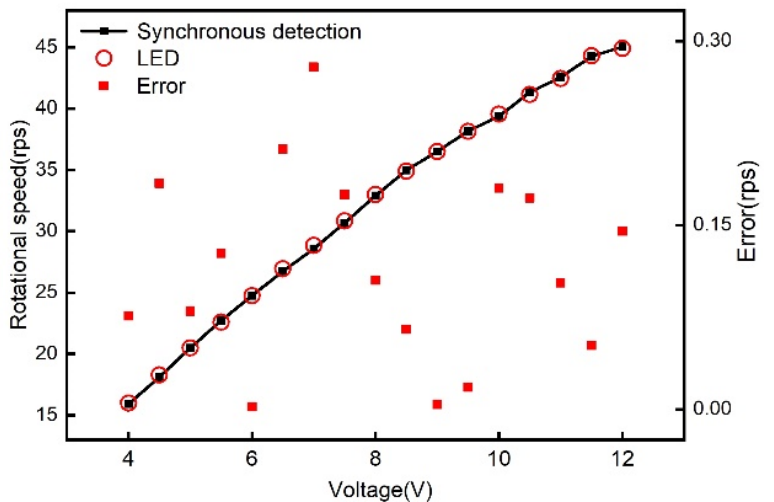
Figure 9. The measured output frequency as a function of rotational speed obtained by the LED detection method.